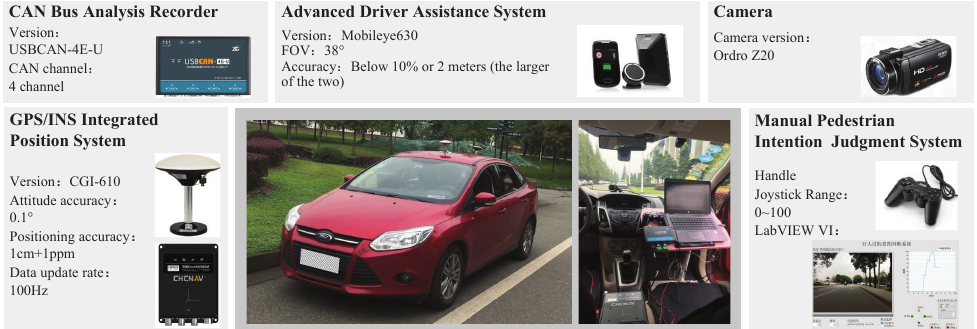
Figure 1. The test platform and its performance parameters.